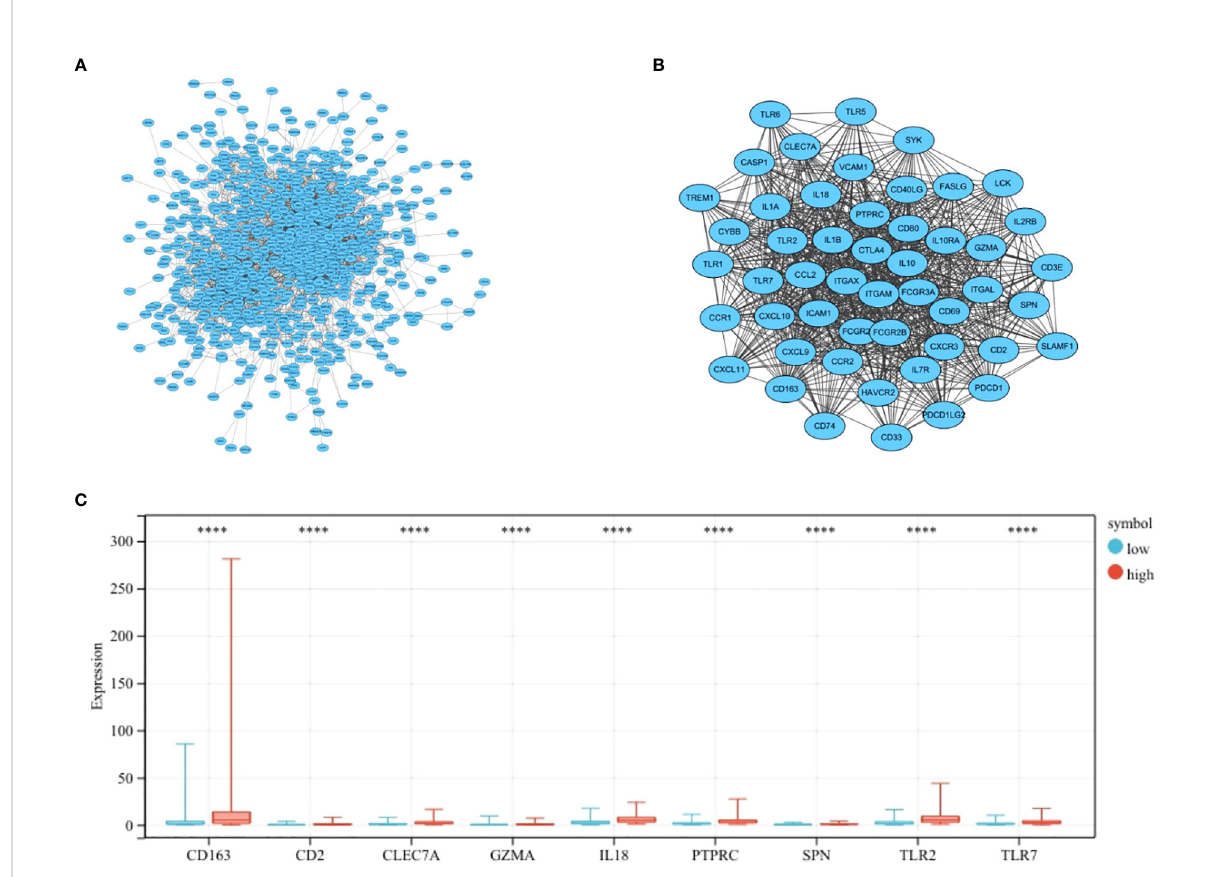
FIGURE 3 Establishment of the PPI network. (A) PPI network showing protein interactions between nodes. (B) Most important modules in the PPI network. (C) Expression of nine prognosis-related genes in the different risk-score groups compared to low group. **** p < 0.0001.